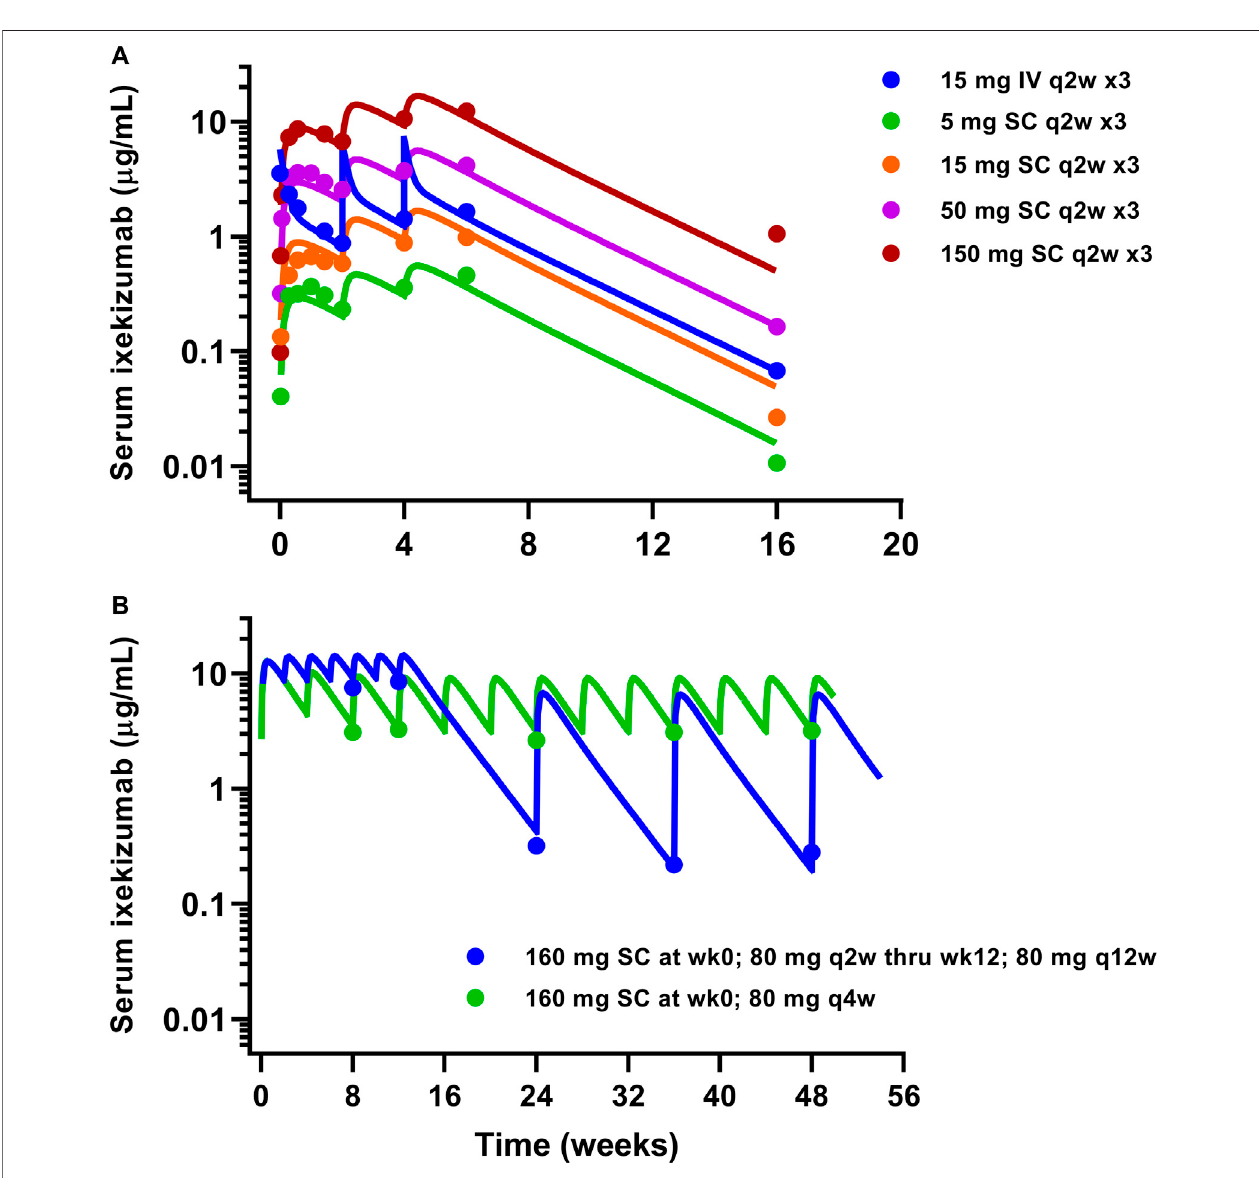
FIGURE4| Model fi ttingofobservedixekizumabmeanserumPKdata. (A) Phase1study(FDA,2016). (B) Phase3studies(Pappetal.,2018).Solidlinesrepresent model- fi tted pro fi les, whereas symbols indicate observed mean data.